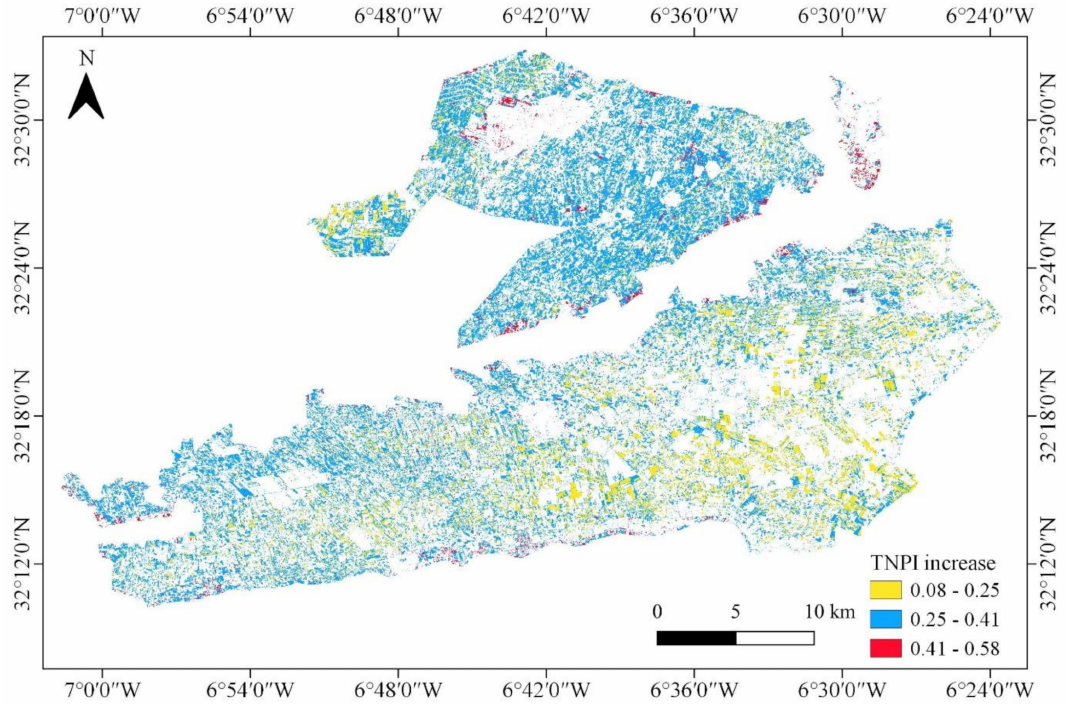
Figure 13. Crop growth increase based on TNPI during two phenological phases (germination and